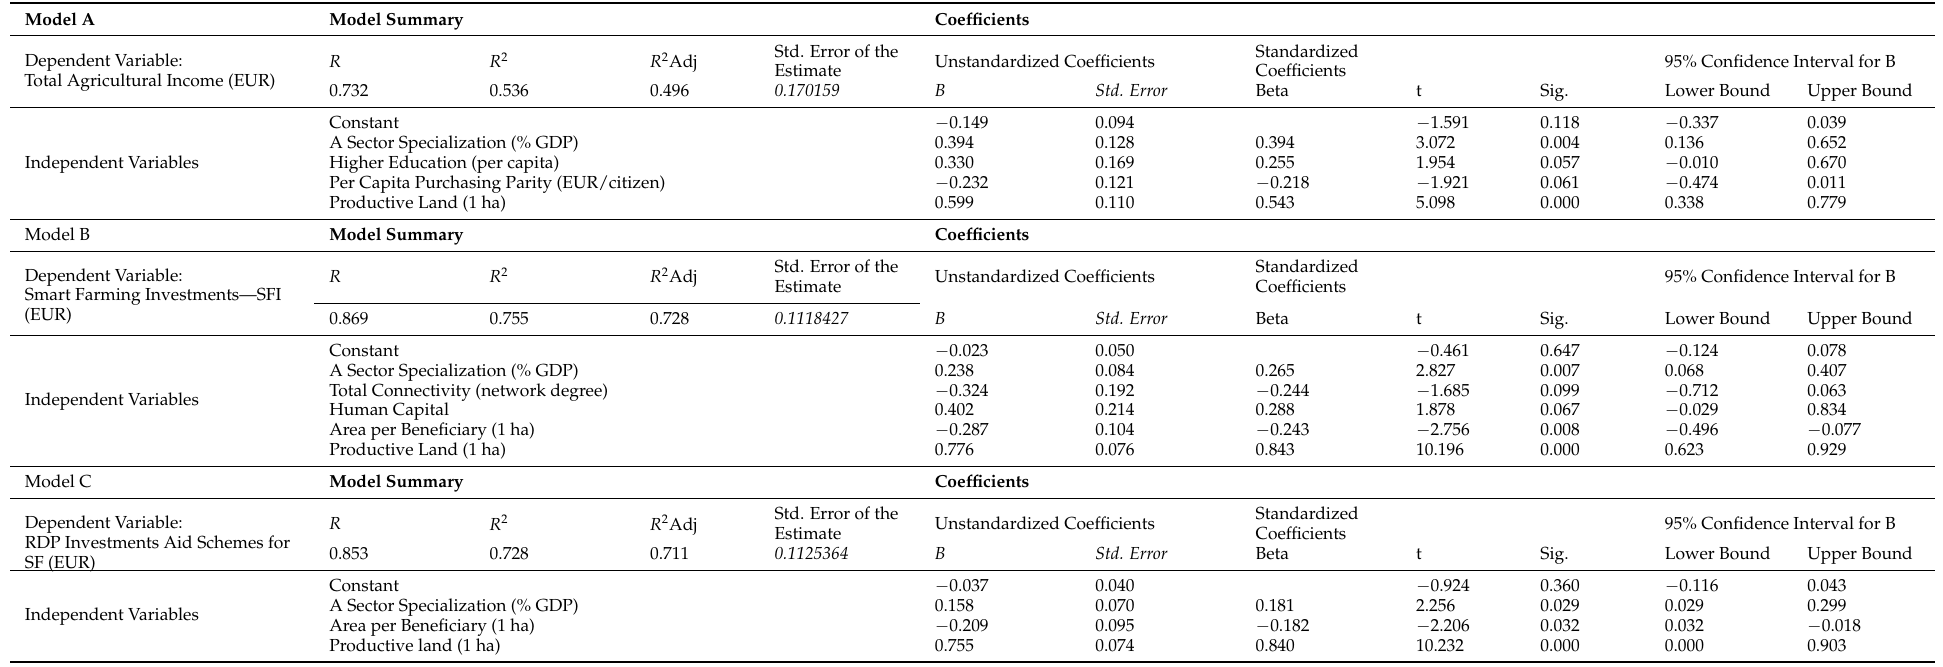
Table 3. Results of the backward elimination method (BEM) linear regression